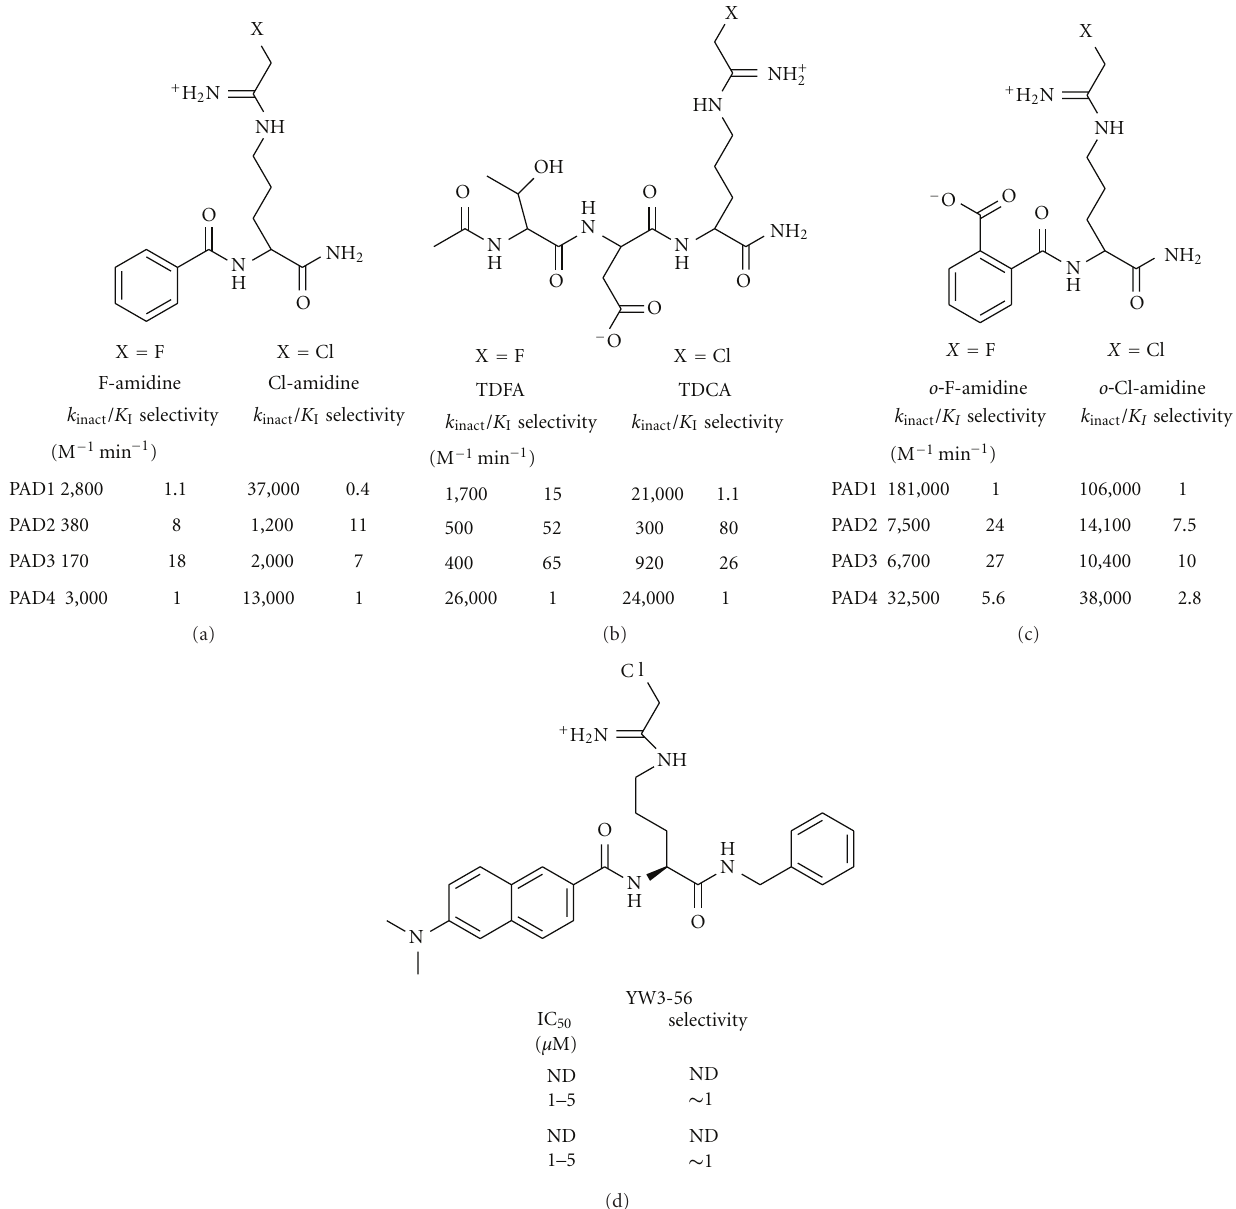
Figure 6: PAD inhibitors and their selectivity (TDFA-Threonine-aspartate-F-amidine;